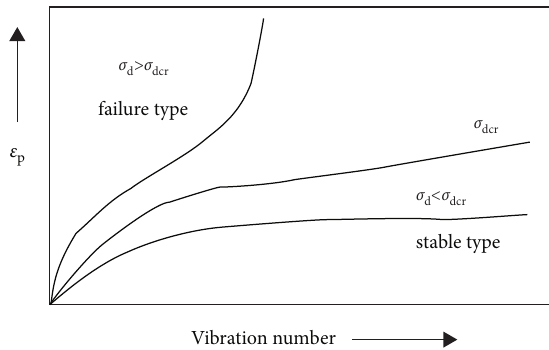
� 200kPa. (b) σ � 300kPa. cyc . (a) σ d d